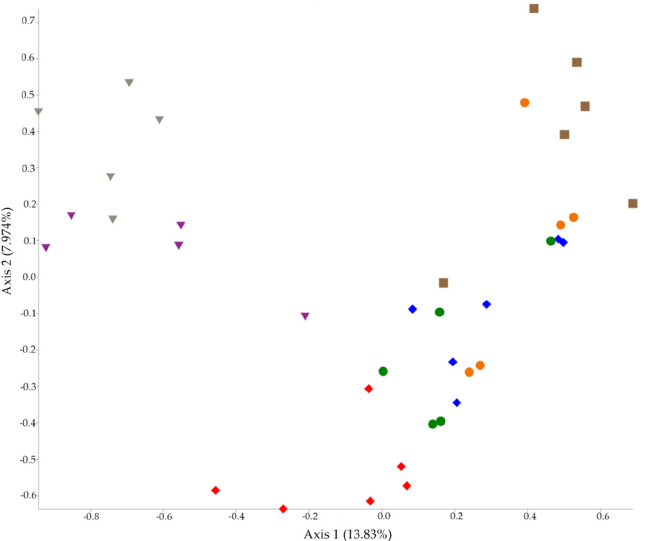
Figure 1. PCoA plot of beta diversity analysis of caecal samples. Amoxicillin group (AMX) (red), amoxicillin + diclazuril group (AMX + DCZ) (blue), thiamphenicol group (THP) (purple), thiamphenicol + diclazuril group (THP + DCZ) (grey), sulfadiazine + trimethoprim group (TRIM) (brown), diclazuril group (DCZ) (orange) and control group (K) (green).